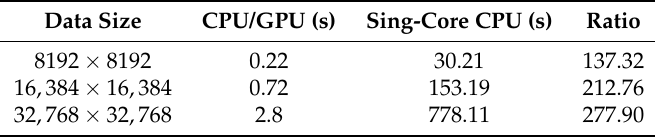
Table 5. Running time of collaborative computing based method.